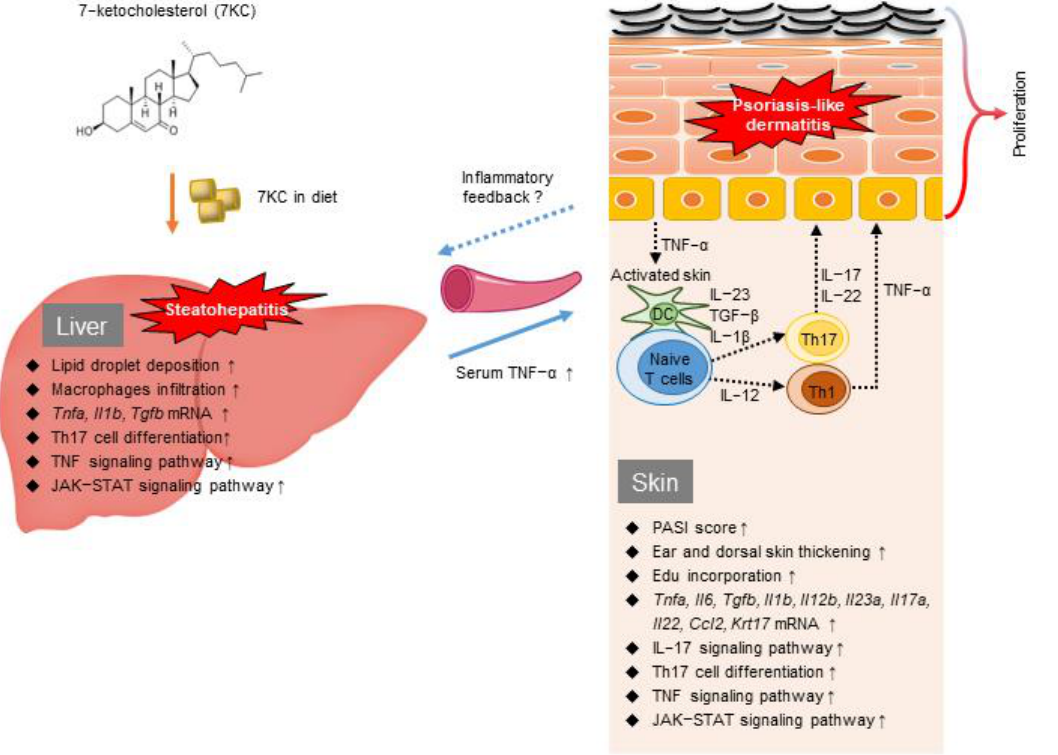
Figure 6. The putative mechanism linking steatohepatitis and psoriasis-like dermatitis stimulated by 7KC and a graphical summary of the current study.